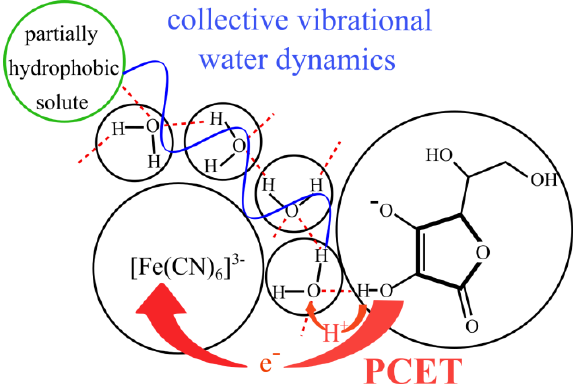
Figure 3. Schematic representation of transition configuration in the PCET ascorbate interaction with hexacyanoferrate(III) ion. Adapted from [23].